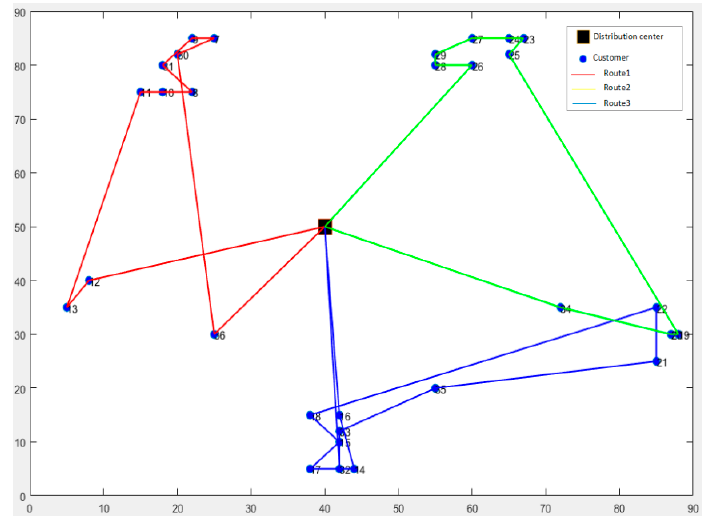
Figure 5. The optimal distribution paths of Capacitated Fuel Vehicle Routing Problem with Time